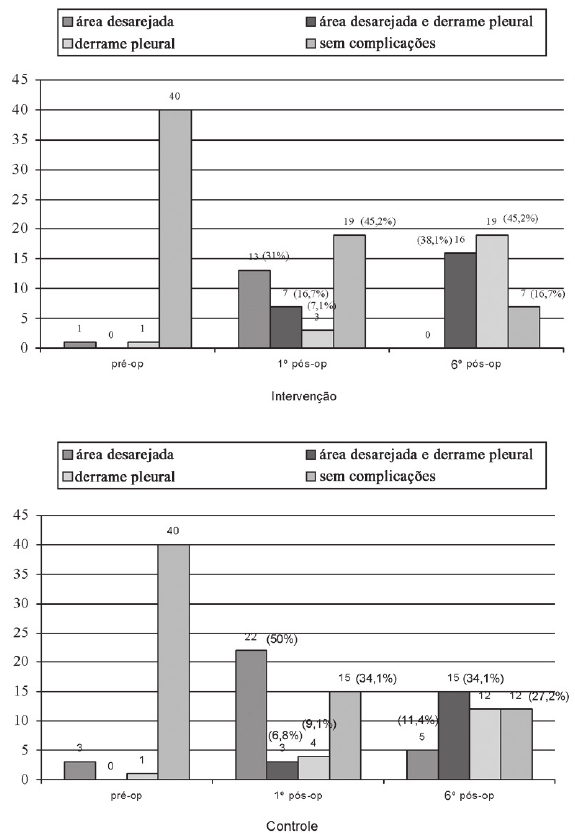
Fig. 4 - Complicações pulmonares pré, 1º e 6º